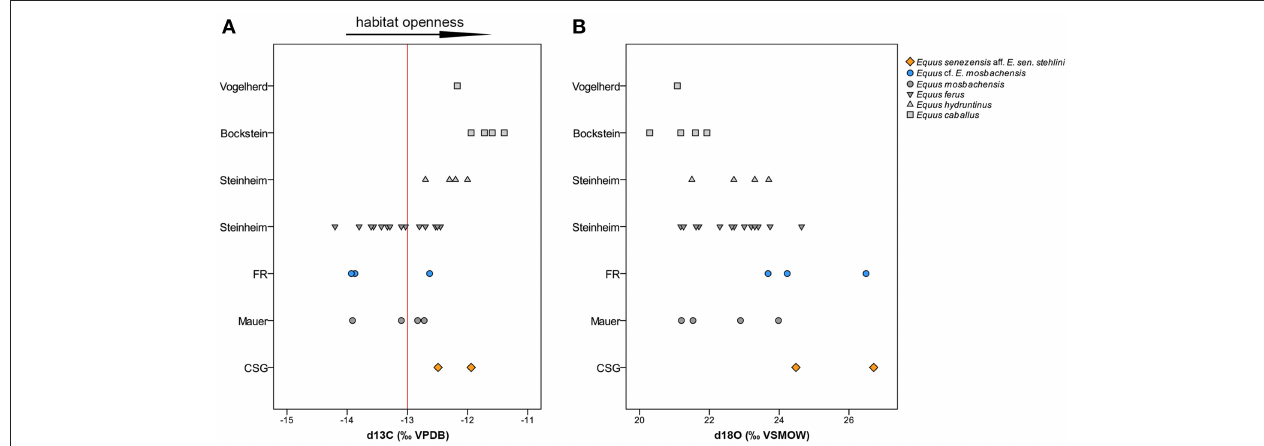
FIGURE 6 | δ 13 C (A) and δ 18 O (B) values of the studied taxa compared to fossil equids of central Europe (data from Pushkina et al., 2014). The red line represents the boundary between δ 13 C values that indicate open ( δ 13 C > − 13 ‰ ) or closed landscapes ( δ 13 C < − 13 ‰ ) in warm temperate and cold boreal environments ( Bocherens,